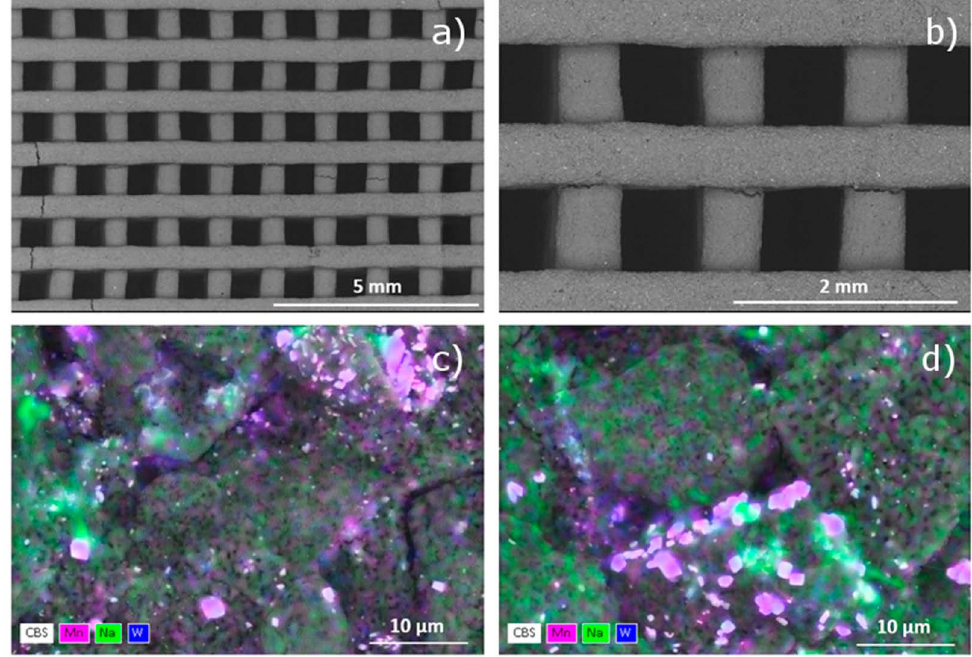
Figure 5. SEM images of 3D printed monolith and its fiber regular arrangement ( a ) and microstructure ( b ) after reaction; EDS mappings ( c , d ) after reaction, showing catalyst material homogenously distributed across silica support with mainly larger grains of Mn and Na phases observed (( a ), scale bar 5 mm; ( b ), scale bar 100 µ m; ( c , d ), scale bar 10 µ m; legend: Mn—fuchsia, Na—green,